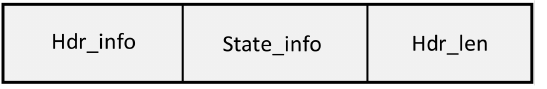
Figure 10. Custom data structure of packet